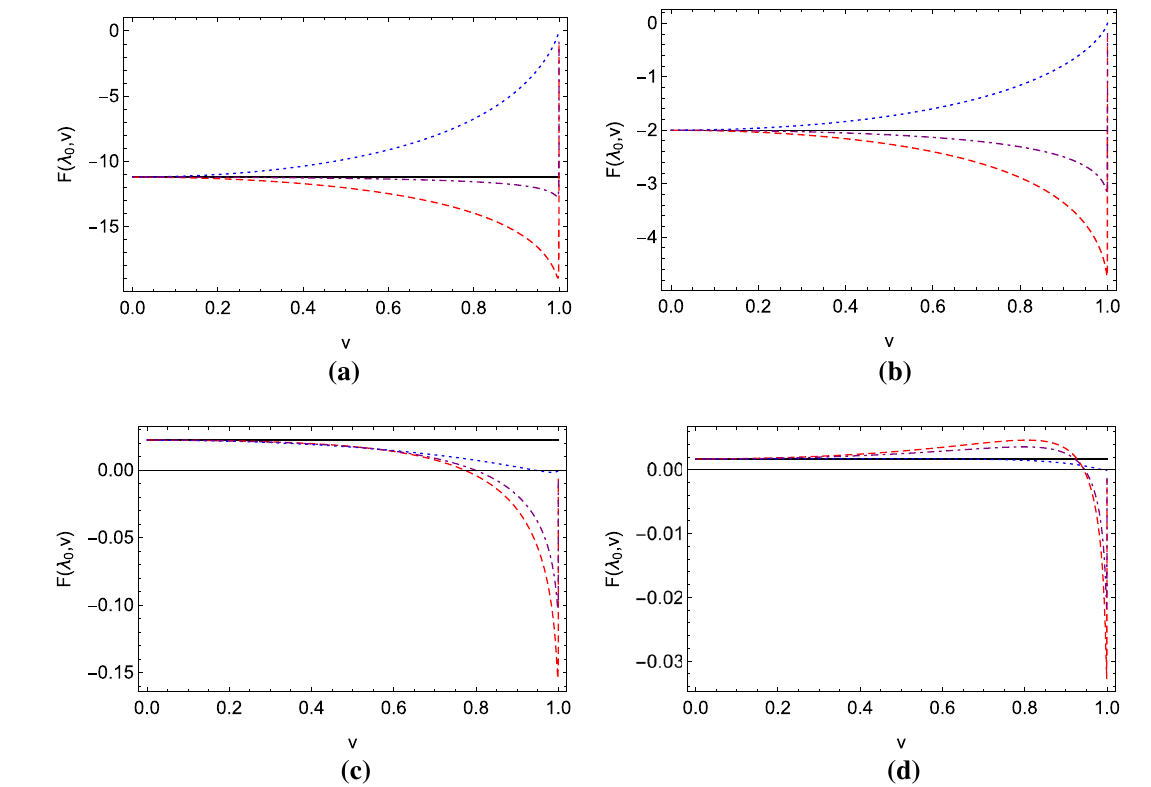
Fig. 2 The behavior of the function F (λ 0 ,v) with the increase in v . The dashed, dotted, and dot-dashed lines refer to the cases for an atom polarizable perpendicular to the atomic velocity, parallel to the atomic velocity, and isotropically, respectively. As a contrast, the transverse